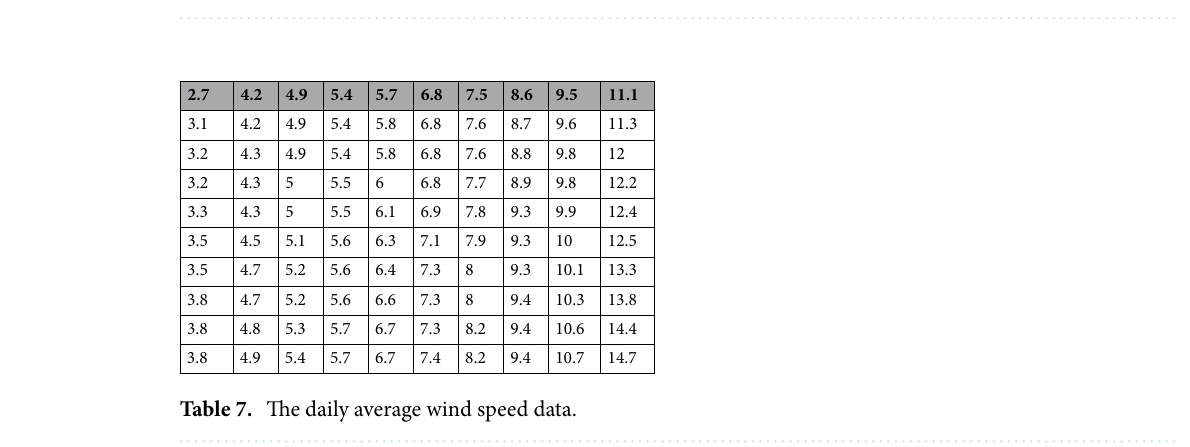
Table 6. The plan parameter when